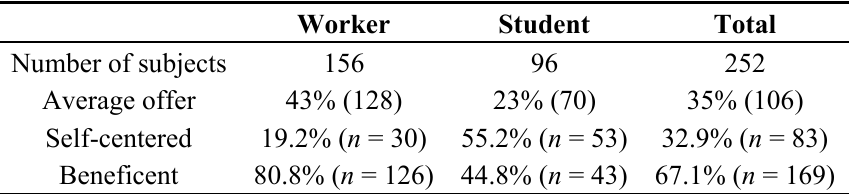
Table A6. Beneficent and Self-centered subjects in the Dictator